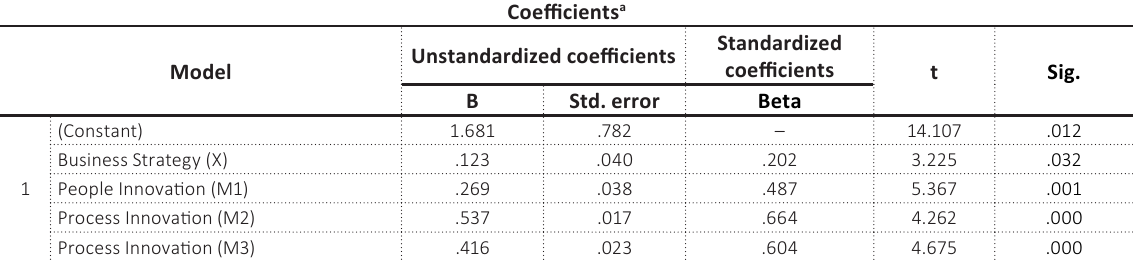
Table 10. Path analysis for the 2 nd regression